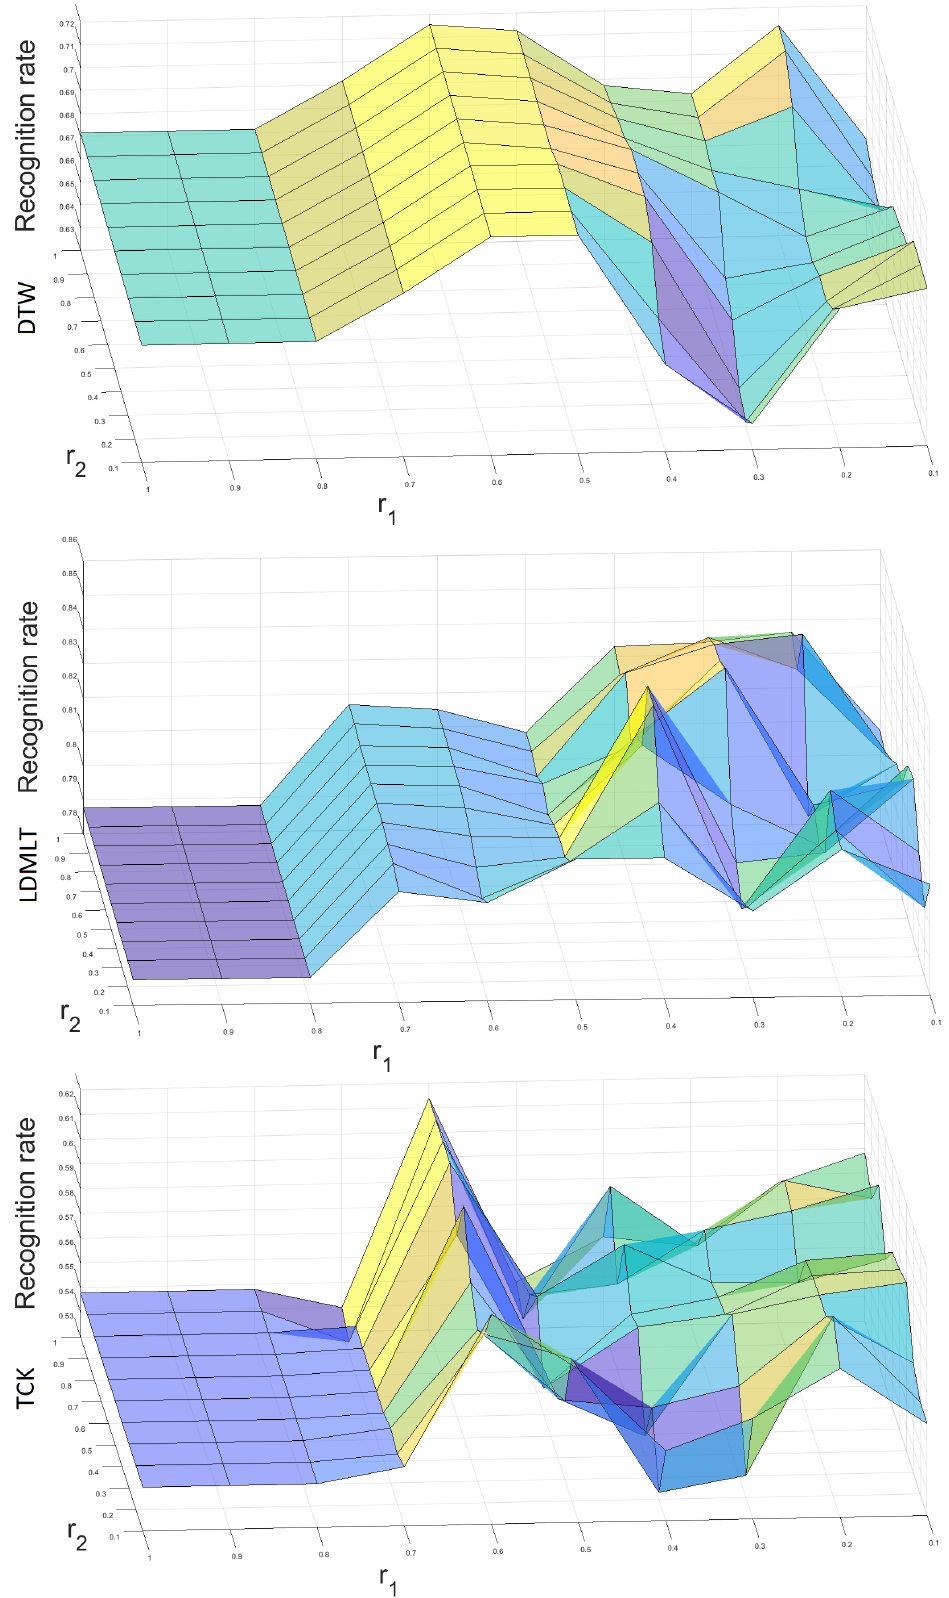
Figure 8. Three-dimensional surface plots presenting the impact of ARSPAWNER parameters r 1 and r 2 on classification accuracy with MSRA II dataset. The upper, middle, and lower plots represent the results of DTW, LDMLT, and TCK,